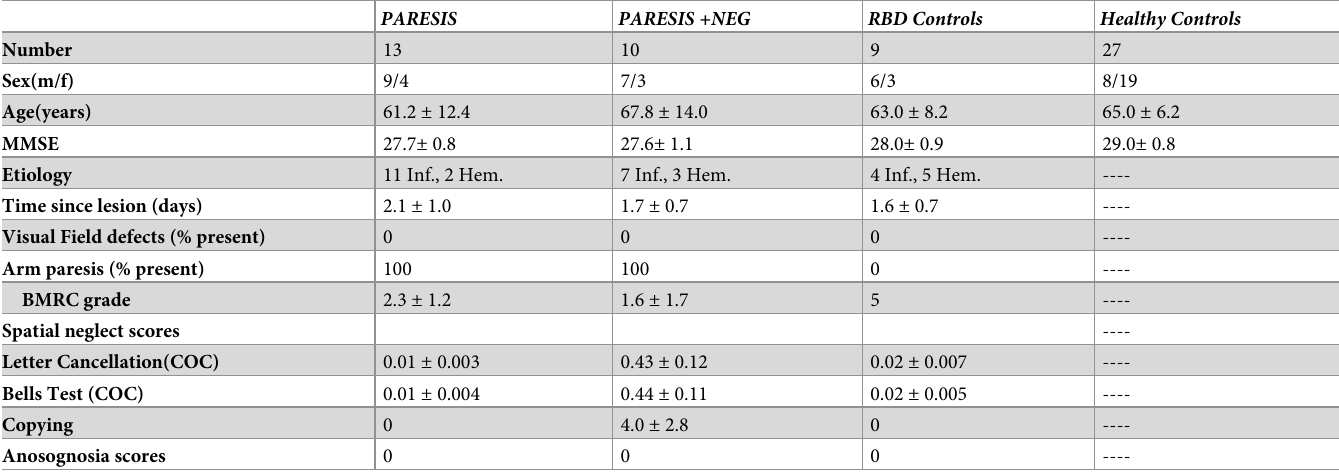
Table 1. Demographic and clinical data of all 59